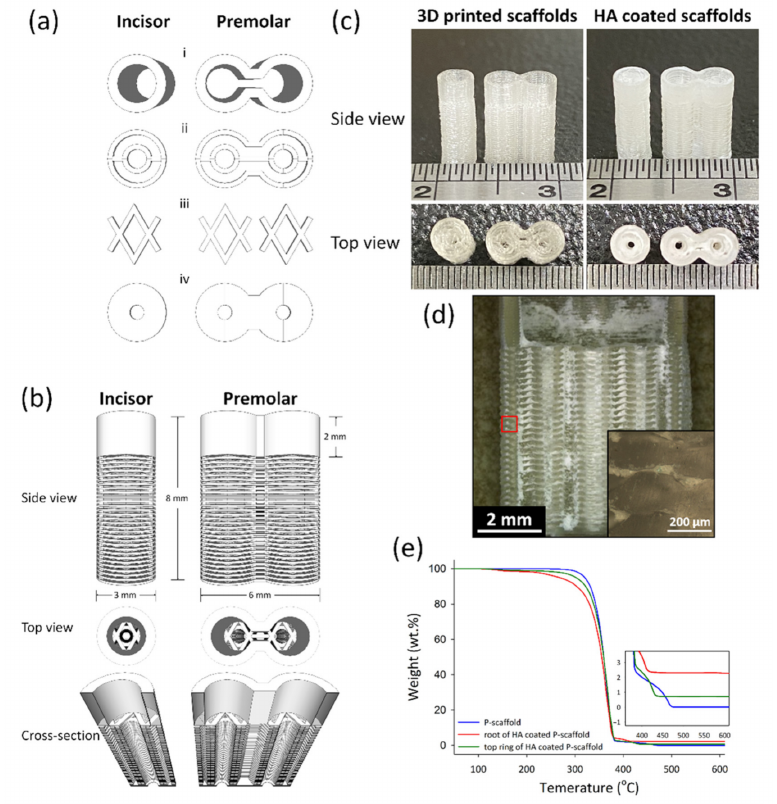
Figure 1. The architecture design of scaffolds and the 3D-printed scaffolds before and after HA coating. ( a ) The basic units to compose scaffolds: the top ring (i), root-circle (ii), spacer (iii) and bottom (iv). ( b ) The side view, the top view, and the cross-section of the designed scaffolds. ( c ) was the side view and top view of I-scaffold and P-scaffold before and after HA coating. ( d ) The cross-section of the HA-coated P-scaffold; the inserted image was the enlargement of the red square. ( e ) The TGA curves of 3D-printed P-scaffold and both the root and the top ring of the HA-coated